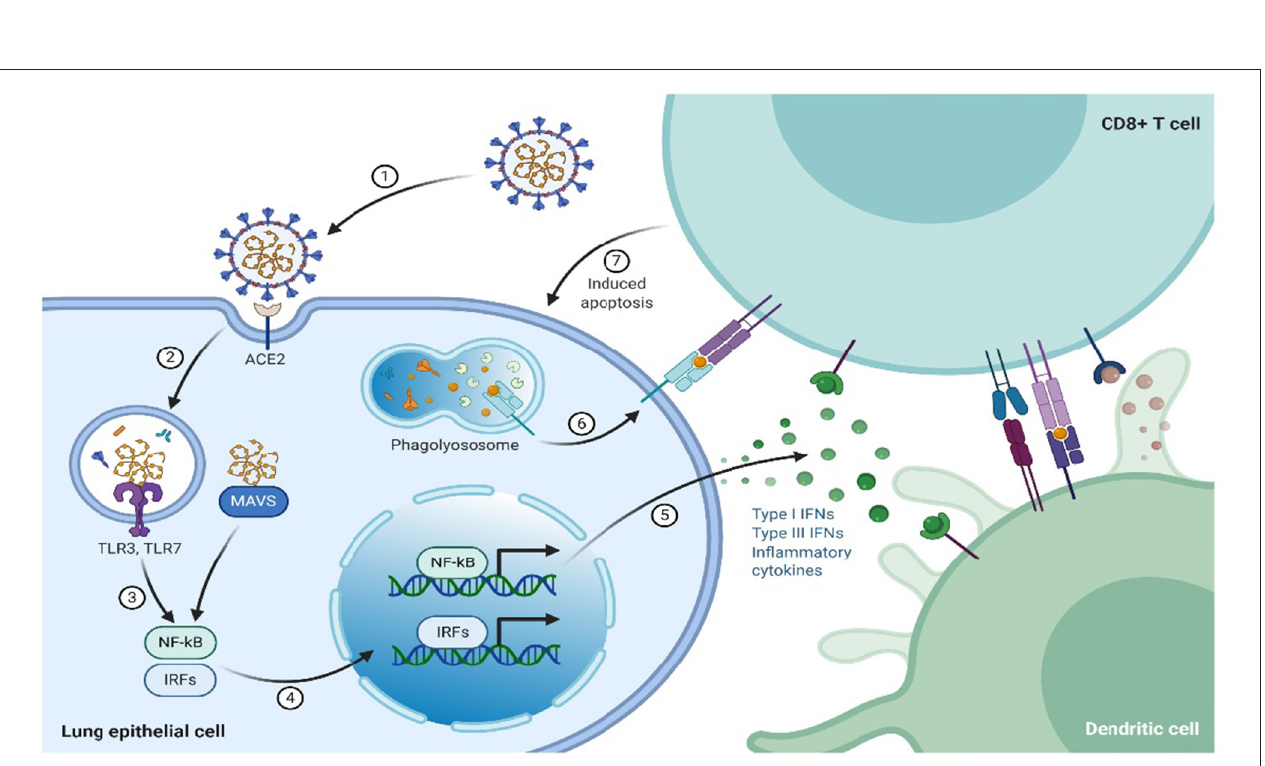
FIGURE 2 | The immune system response to